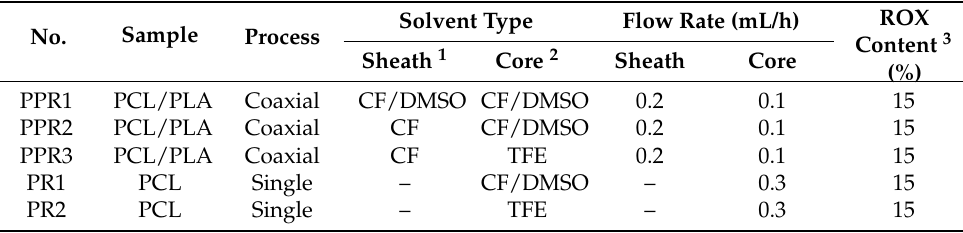
Table 1. Experimental parameters for the fabrication of the different nanofibers.